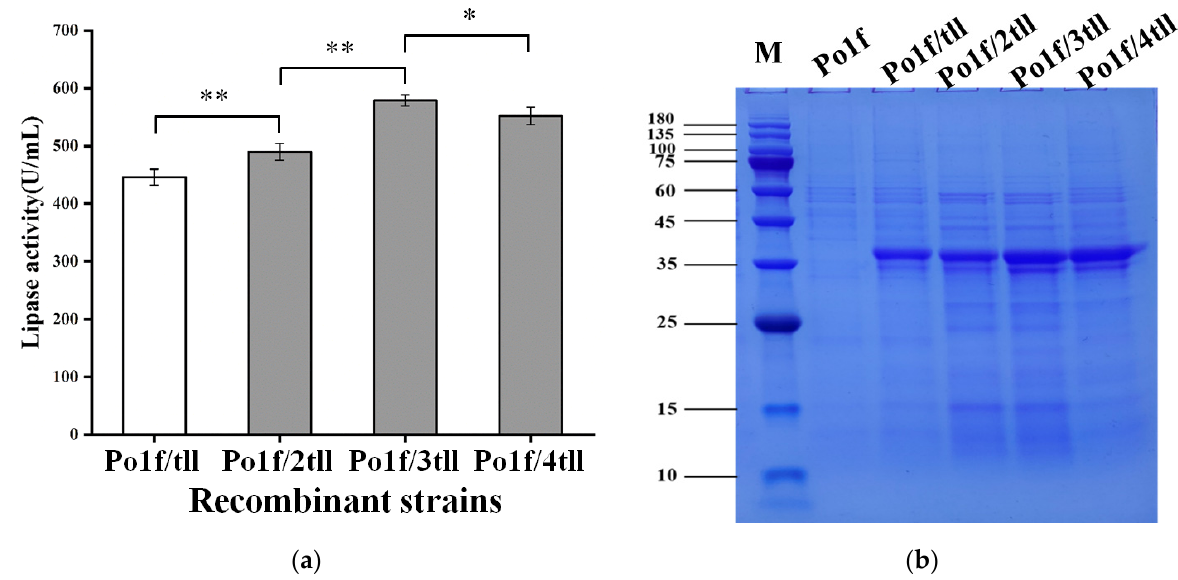
Figure 5. Cultivation results of the recombinant strains Po1f/ntll (n = 1, 2, 3, and 4) harboring different copies of tll gene in shaking flasks. ( a ) TLL activity; Statistical significance was calculated by unpaired T-test analysis. *: p < 0.05; **: p < 0.01. ( b ) SDS-PAGE analysis.